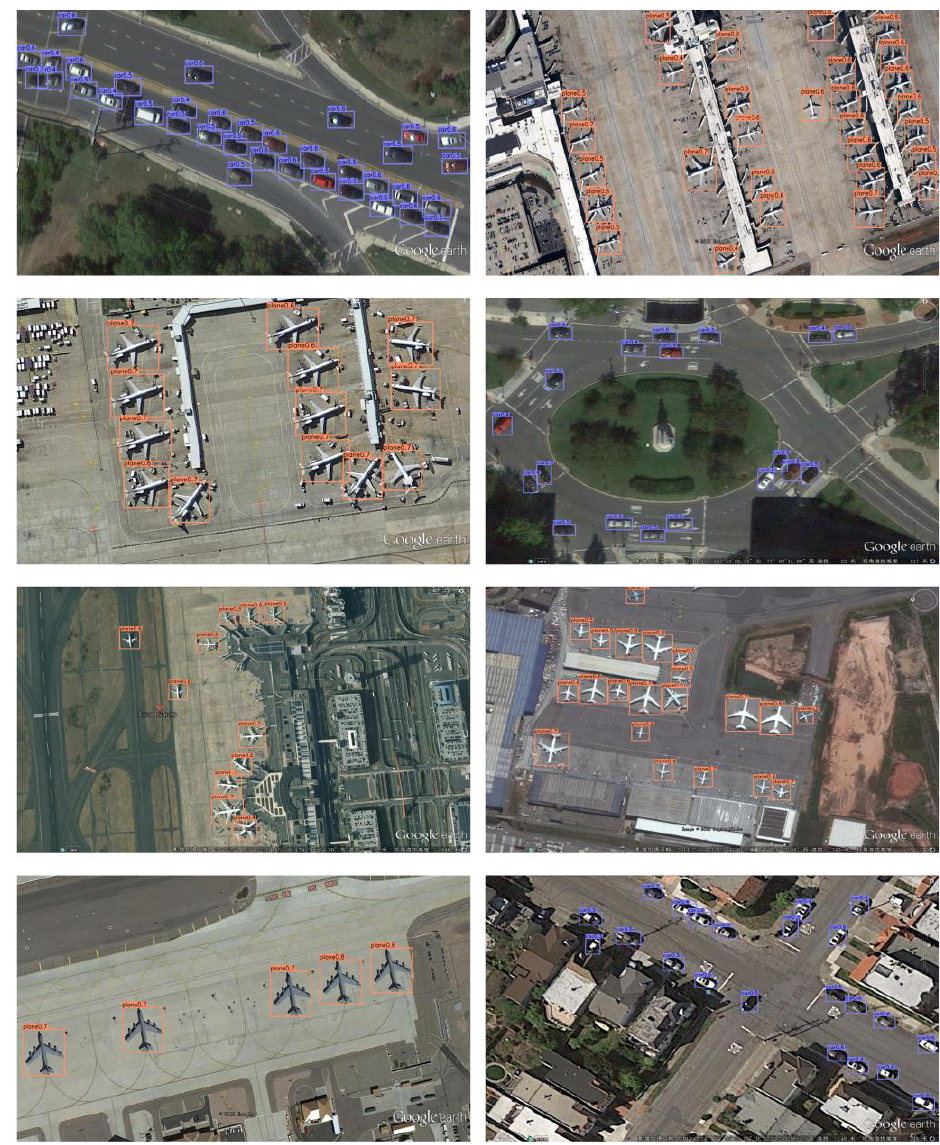
Figure 8. Detection illustration on the UCAS-AOD dataset. Table 6. Evaluation results on the LEVIR dataset. Compared with the original networks, the proposed detector results in improvements of 1.9%, 4.3%, and 4.4% respectively on AP for the plane, ship, and oil-tank dataset. The mAP is improved from 0.828 to 0.863 with a increasement of 3.5% by using dynamic gradient adjustment mechanism and CioU regression module. Figure 9 shows some detection results on the LEVIR by using the proposed DGANet